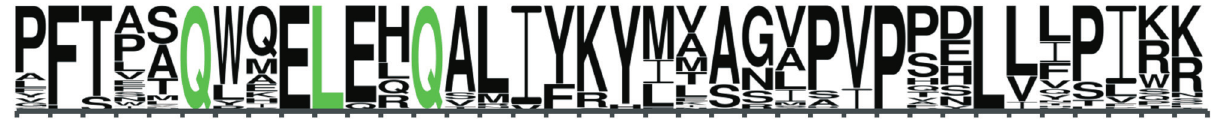
Figure 5 - Structural organization of GRF genes. QLQ and WRC coding sequences of GRFs of P. patens (Pp), A. thaliana (At), and O. sativa (Os) were usedtogenerateaphylogenetictreebyBayesianinference(linewidthbyposteriorprobability).Thegraphicalrepresentationofgenestructureswasbased on genomic information available at Phytozome. Gray color corresponds to 5’ and 3’ untranslated regions. Black bars and lines indicate exons and introns,respectively.Thedifferentdomainsarecoloredingreen(QLQ),pink(WRC),orange(TQL),blue(TQL),andpurple(GGPL).Forscale,QLQdo- main (green) corresponds to 118bp.